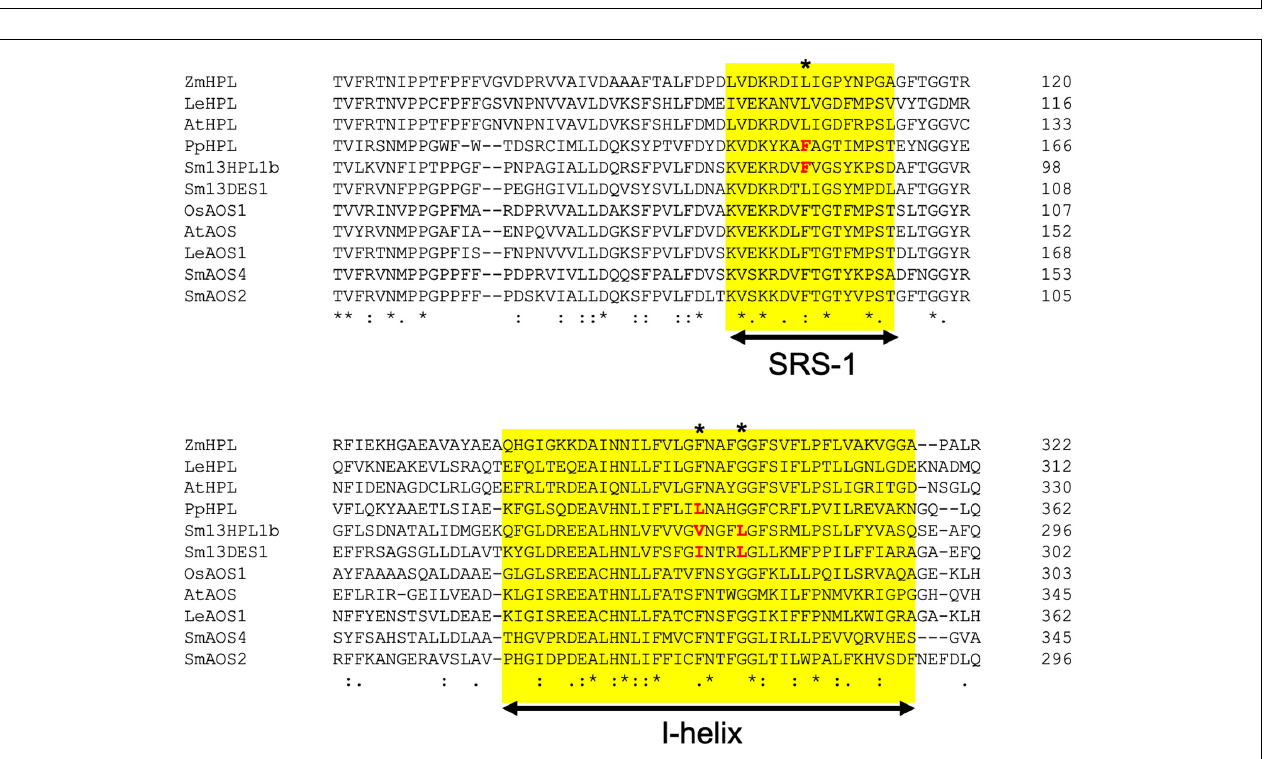
FIGURE 8 | Multialignment of representative seed plant HPLs and AOSs with SmHPL1b, SmDES1, SmAOS4, and SmAOS2. The substrate recognition site (SRS)-1 and I-helix are highlighted with yellow background. The amino acids specific to non-seed CYP74s are shown in red. The position of F/L toggle is shown with